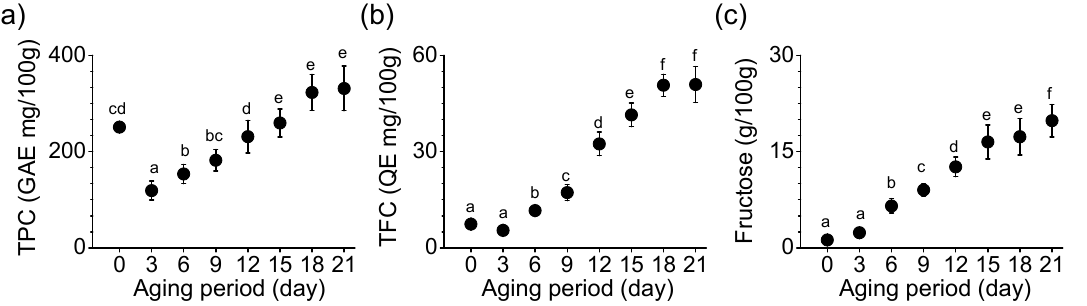
Figure 2. Changes in ( a ) TPC, ( b ) TFC, and ( c ) fructose content during the aging of SRG. Each point represents the mean ± SD (n = 6). Based on Duncan’s multiple range test, different letters indicate significant differences between the same sample ( p <